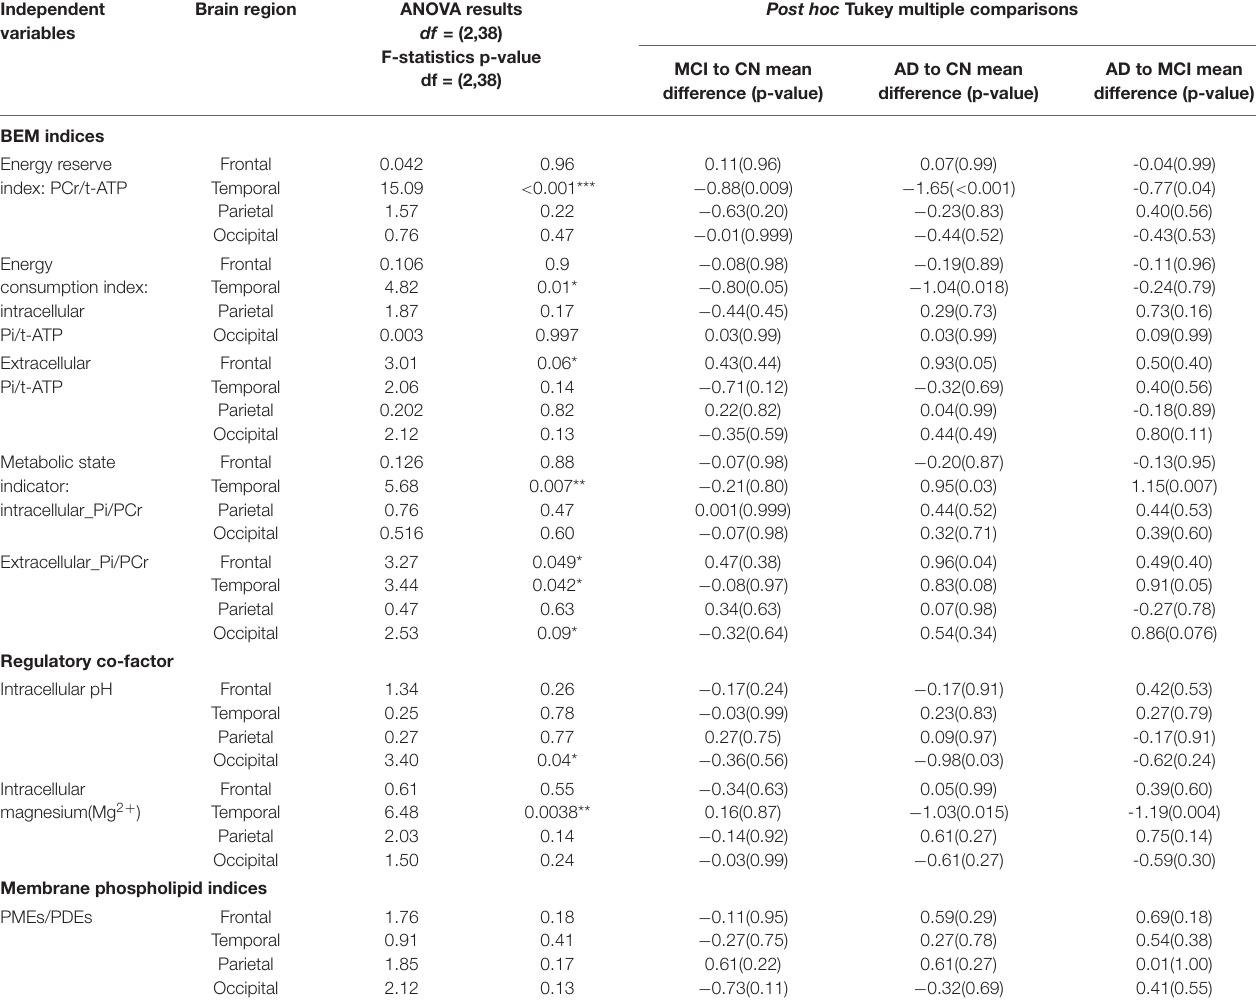
TABLE 3 | ANOVA analysis of p-BEM markers, Regulatory co-factors (Magnesium and pH), and membrane phospholipid markers in the four brain regions-frontal, temporal, parietal, and occipital across the three cohorts: cognitively normal (CN) adults, amnestic mild cognitive impairment (aMCI), and mild Alzheimer’s disease (AD) (*indicates those F tests which satisfy FDR = 0.10). Tukey post hoc analysis for the significant group